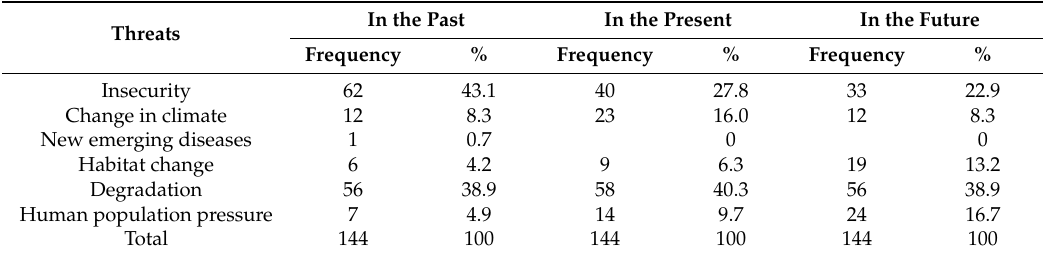
Table 1. Perceived threats to the Mt. Marsabit forest ecosystem ( n = 144).